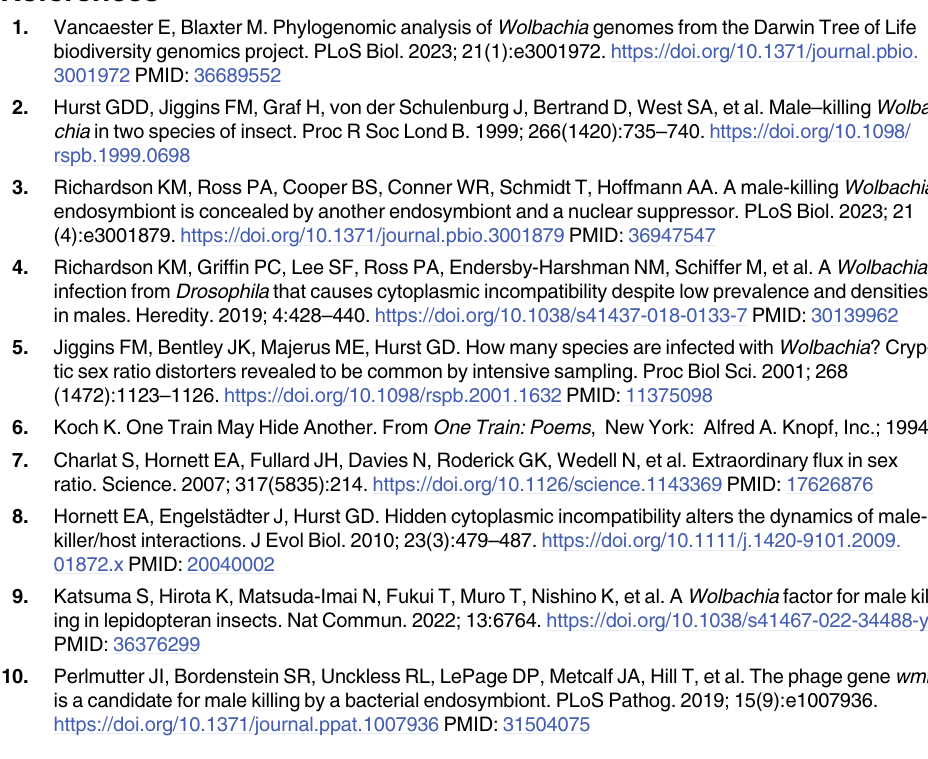
Fig 1. Traditional nonspecific PCR assays for symbiont infection will miss rare coinfections. In this graphic, the natural population comprises flies either with a single infection (blue: strain 1) or a double infection including the male-killer (green: strain 1 + strain 2(MK)). ( A ) In a PCR survey, both male and female individuals test positive for Wolbachia because of the high prevalence non-MK Wolbachia infection, obscuring evidence of MK in the population. ( B ) In the current paper, female flies from natural populations are allowed to individually oviposit. Egg hatch rate is noted (embryonic MK results in the death of half of the embryos; late MK results in the death of larvae—as observed in the current study). The sex ratio (SR) of the surviving adult progeny is determined (a female bias (0:1) is produced upon infection with a MK). When DNA is extracted from these flies and the Wolbachia amplicon Sanger sequenced, double peaks suggest coinfection. Genome sequencing confirms the presence of > 1 strain of Wolbachia , the second strain being the male-killer. Figure created with